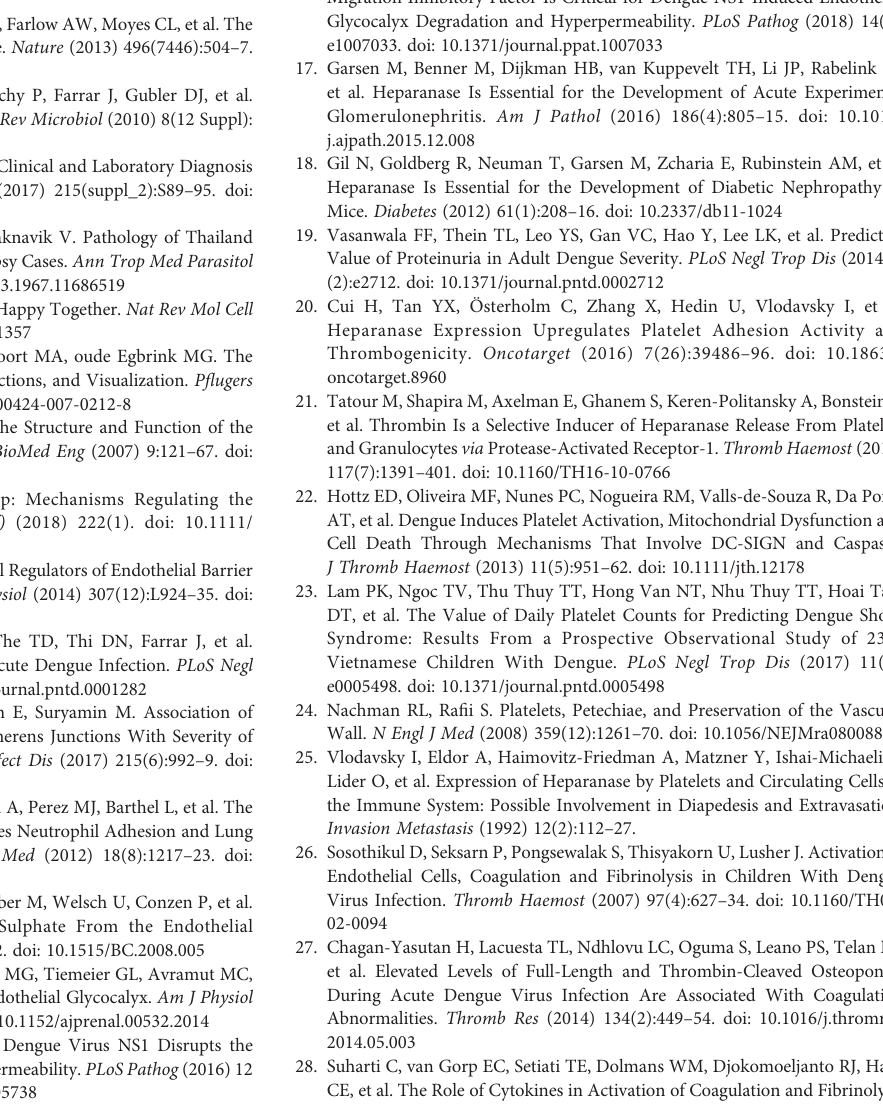
Supplementary Figure 1 | Relationship of HPSE activity with hematocrit concentration and plasma albumin level as clinical parameters of plasma leakage. Correlations of HPSE activity in plasma at day of admission (day 0) and day 1, 2 and 3 with (A) . hematocrit concentration and (B) . plasma albumin level. Data are presented as individual values for each patient and correlation analysis was performed with Spearman ’ s correlation coëf fi cient (*p < 0.05, **p < 0.01). HPSE, heparanase; AU, arbitrary units. Supplementary Figure 2 | Relationship of HPSE activity with gall-bladder wall thickness and albumin-creatinine ratio as clinical parameters of plasma leakage.